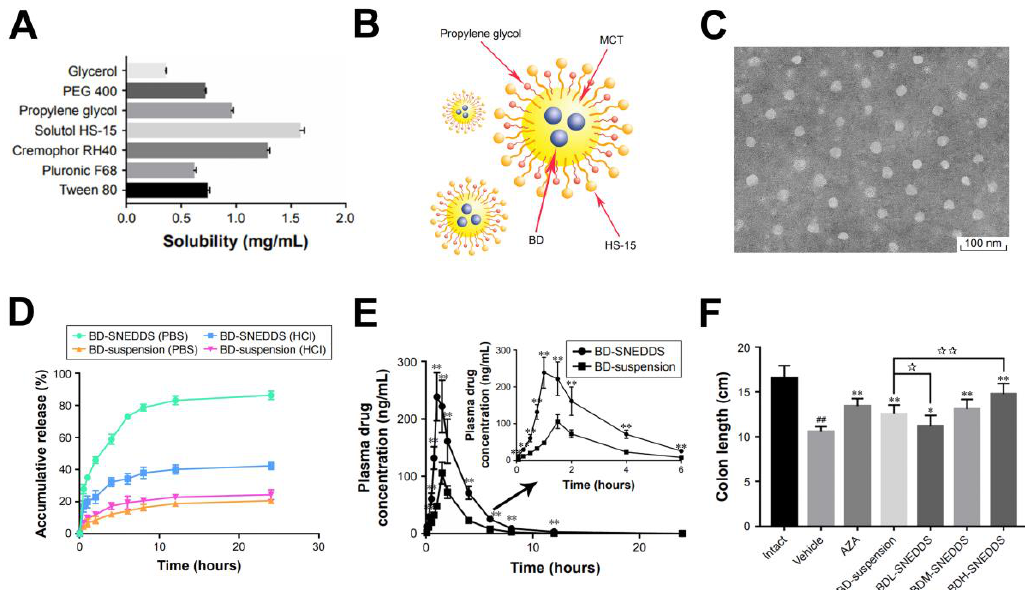
Figure 3. ( A ) Solubility of bruceine D (BD) in different excipients; ( B ) Schematic diagram of BD in the self-nanoemulsifying drug delivery system, which was termed BD-SNEDDS and consisted of BD in medium-chain triglyceride (MCT) oil and encapsulated within PEG-15-hydroxystearate (HS-15) and propylene glycol cosurfactants; ( C ) Transmission electron microscopy (TEM) image of BD-SNEDDS nanoemulsions; ( D ) In vitro release profiles of BD in BD-SNEDDS nanoemulsions and in an aqueous suspension in simulated intestinal fluid comprising phosphate-buffered saline (PBS) (pH 6.8) and in simulated gastric fluid comprising HCl (pH 1.2) conditions; ( E ) Mean concentration of BD in rat